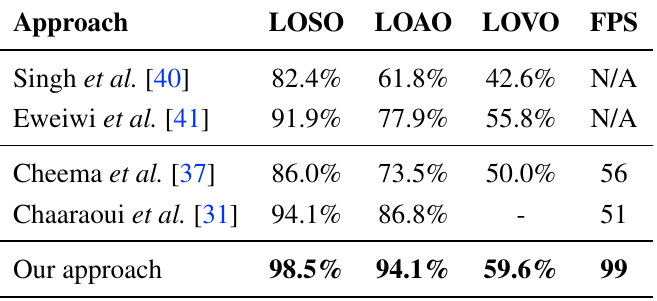
Table 5. Comparison of recognition rates and speeds obtained on the MuHAVi-14 dataset with other state-of-the-art